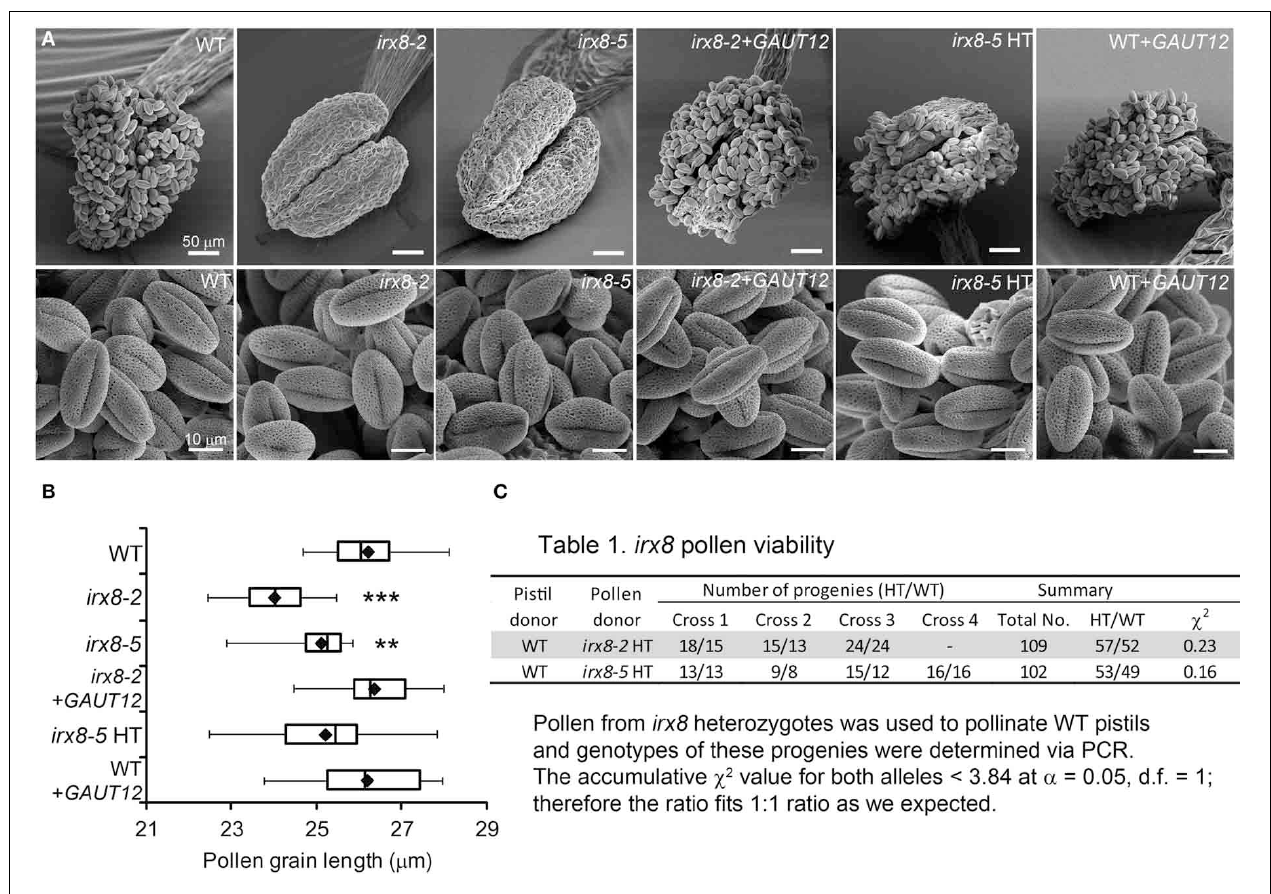
FIGURE 3 | SEM of anthers and pollen grains (PG) from irx8 and GAUT12 -transgenic plants. (A) SEM images of anthers and PG from open flowers of WT, irx8-2 , irx8-5 , irx8-2 + GAUT12 , irx8-5 heterozygote (HT), and WT + GAUT12 . Bar = 50 μ m in upper panel and = 10 μ m in lower panel. (B) Box plot diagram of PG length measured under SEM of WT ( n = 10), irx8-2 ( n = 19), irx8-5 ( n = 21), irx8-2 + GAUT12 ( n = 20), irx8-5 HT ( n = 26), and WT + GAUT12 ( n = 25). n , number of PG measured. The One-Way ANOVA was significant and a Bonferroni corrected post-hoc t -test indicates that PG length is significantly smaller